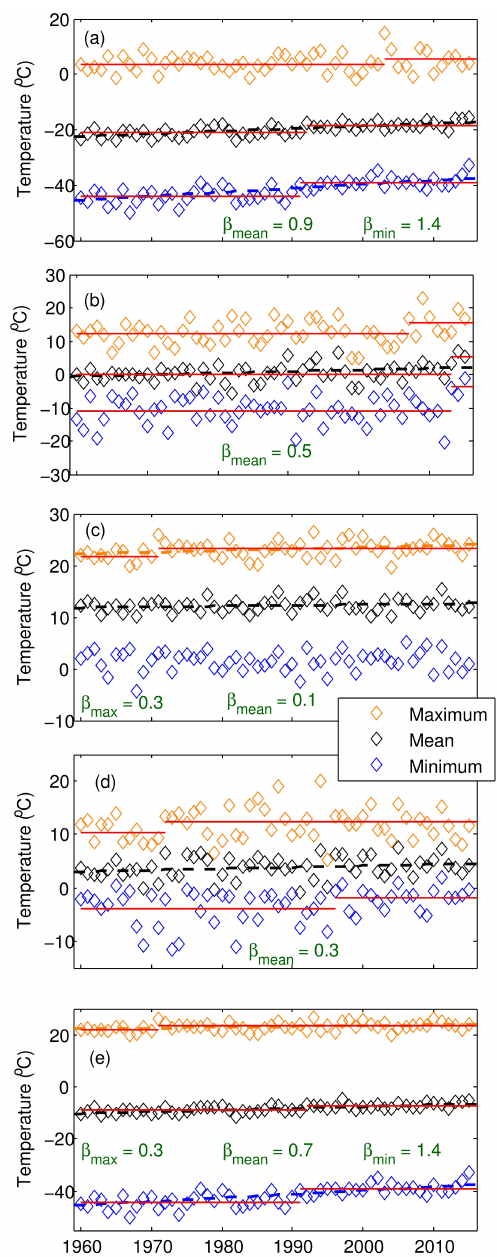
Figure 5. Observed seasonal and annual maximum, mean and min- imum temperature for each water year (October–September) cal- culated from mean daily temperature, between 1960 and 2015. (a) Winter (October–April), (b) spring (May), (c) summer (June– August), (d) fall (September) and (e) annual. The dashed line is the linear regression using Sen (1968). The slope ( β ) in ◦ Cdecade − 1 for statistically significant trends at the p ≤ 0 . 05 significance threshold is shown. The solid red line shows the annual change